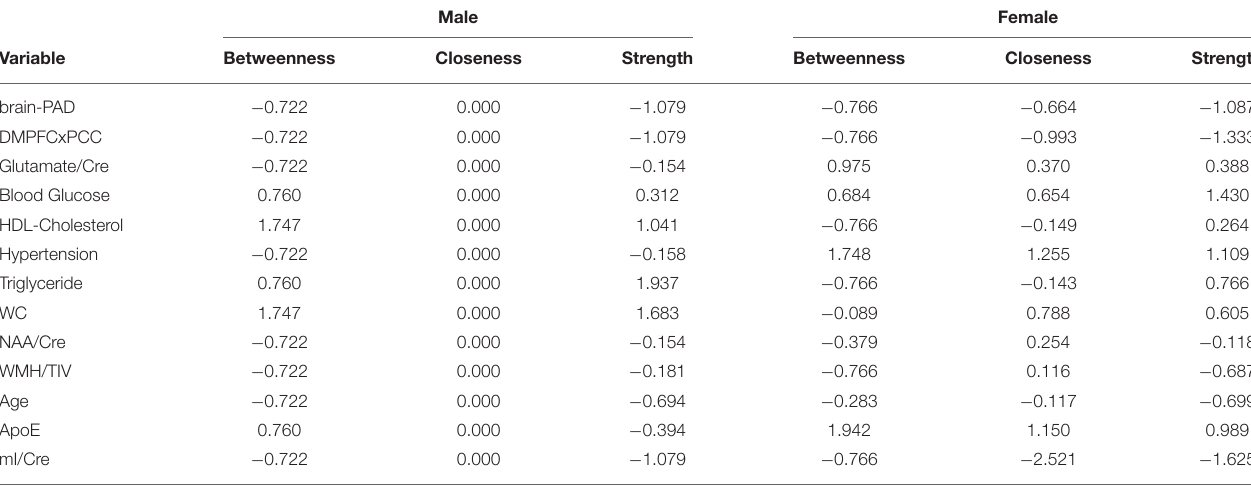
TABLE 2 | Centrality measures for each node including betweenness (which nodes serve as bridges between other nodes in the network), closeness (relative closeness of a node to all other nodes in a network), and degree/strength (how many direct connections a node has with other nodes). Male